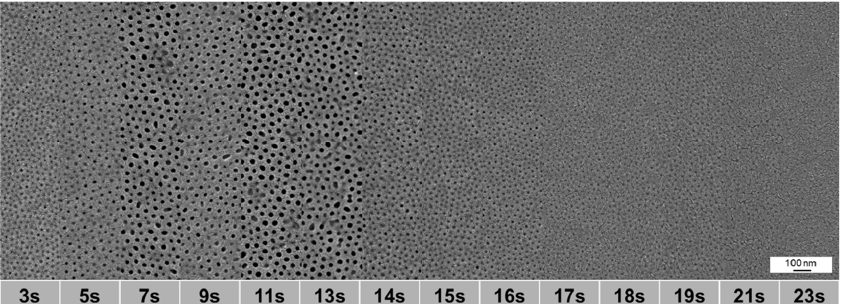
Figure 15. SEM images of spray cast samples of PS 83 - b -P4VP 1788 solution in dioxane (1 wt%) with a 2- fluid nozzle and different evaporation times (from 3 to 23 s), p(G) = 1.8 bar gas, p(L) = 2.2 bar, d(NS) = 15 cm, d(NN) = 4 cm.